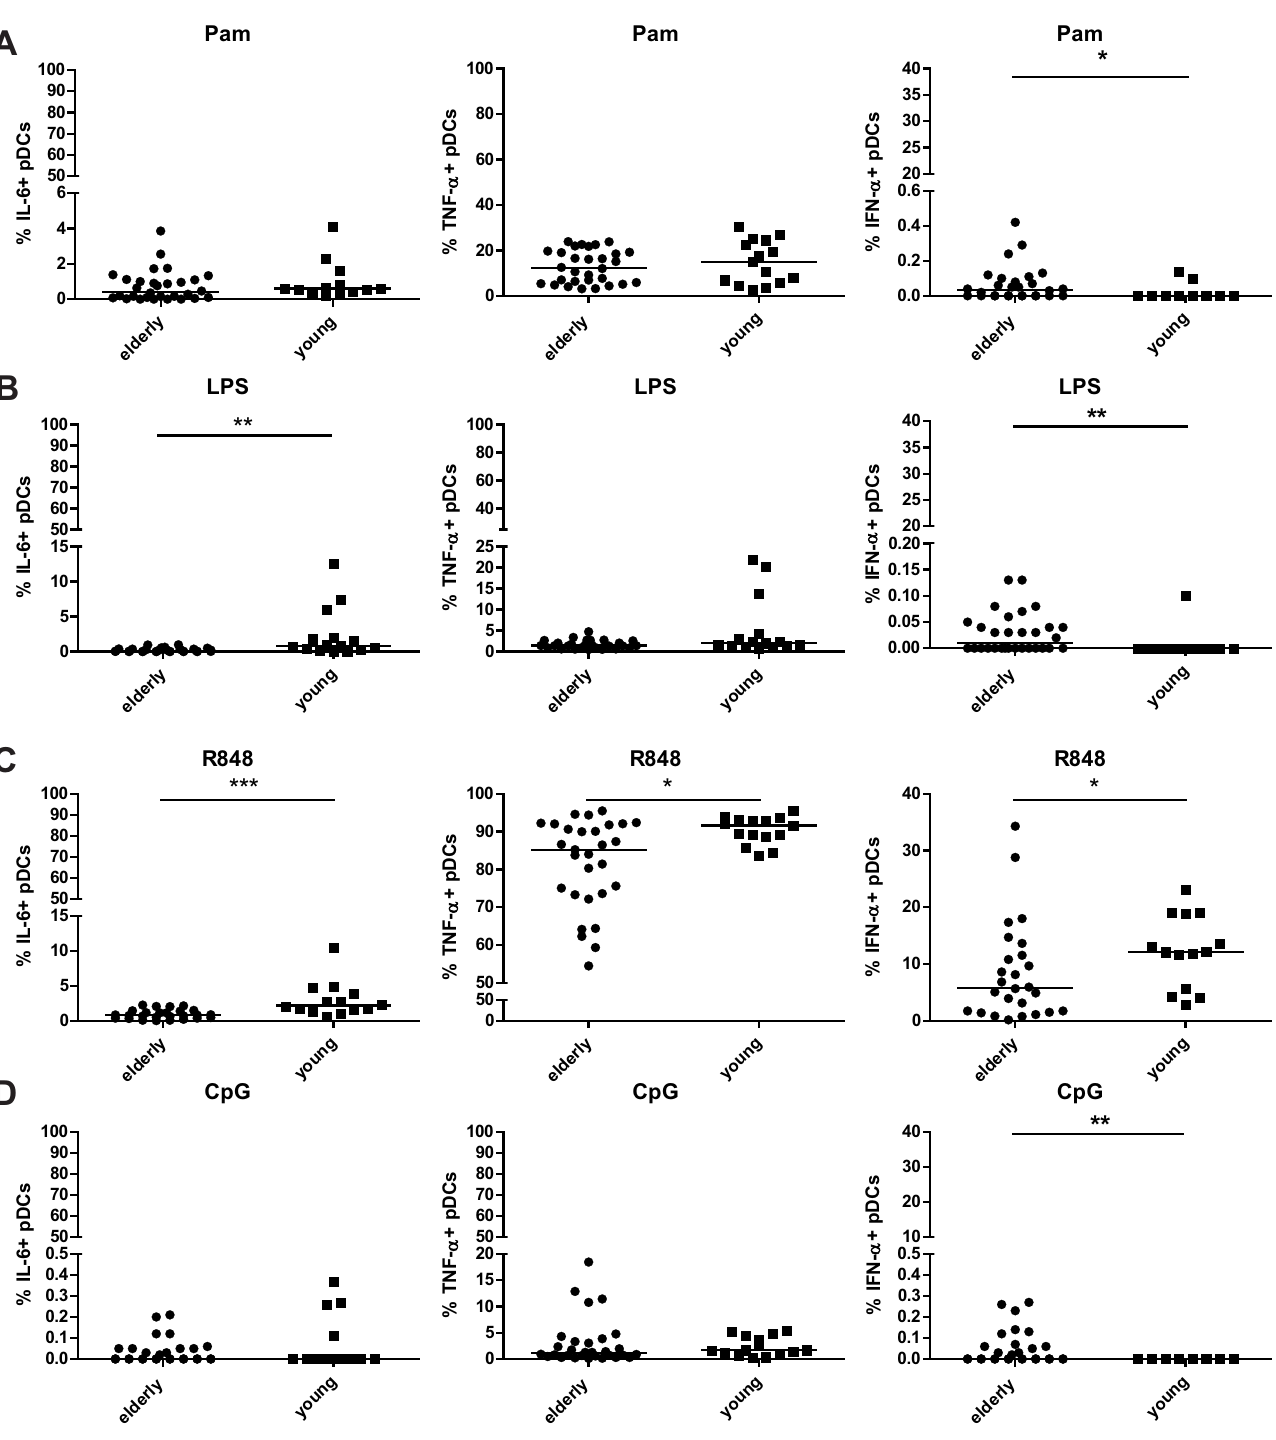
Fig 3. Intracellular cytokine production (IL-6, TNF- α and IFN- α ) of pDCs upon TLR1/2 (A), TLR4 (B), TLR 7/8 (C) and TLR9 (D) stimulation in young versus older adults. Data shown as dot plots with median, every dot represents a donor, outliers with > 2SD based on transformed data were removed. Elderly n = 30; young n = 15 donors. Statistics were done with logit or rank transformed data using MANOVA per TLR stimulation with a pairwise comparison and a bonferroni correction. � p < 0.05; �� p < 0.01; ��� p <